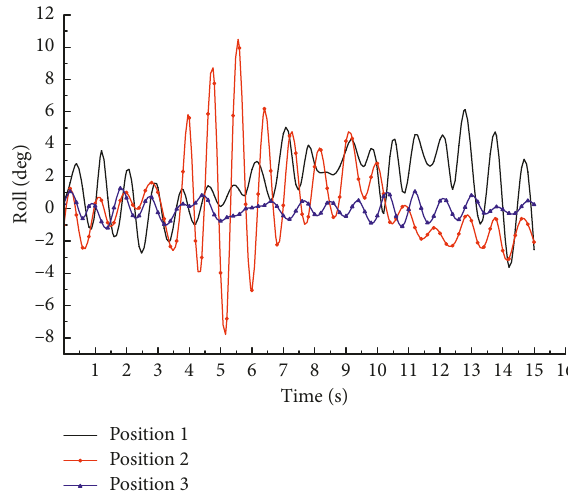
Figure 14: Time history curve of the rolling motion of the ship under different navigational positions.